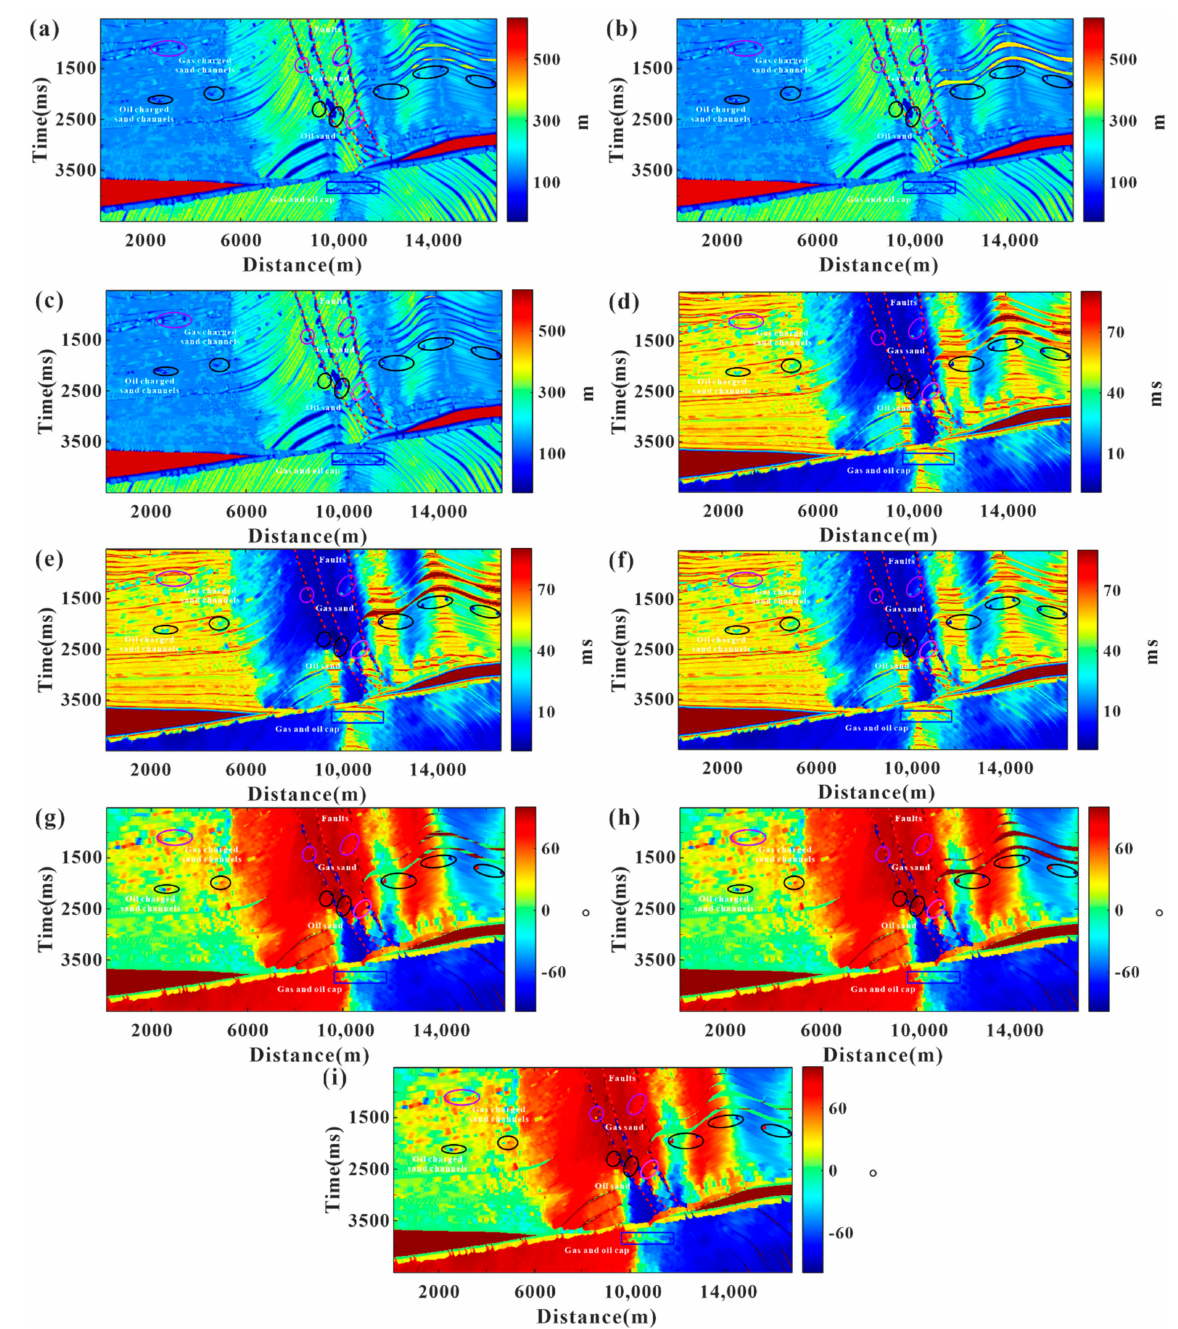
Figure 10. Estimation results of autocorrelation parameters of porosity, clay volume, and water saturation: ( a – c ) are the horizontal autocorrelation length of porosity, clay volume, and water saturation, respectively. ( d – f ) are the vertical autocorrelation length of porosity, clay volume, and water saturation, respectively. ( g – i ) are the autocorrelation angle of porosity, clay volume, and water saturation,